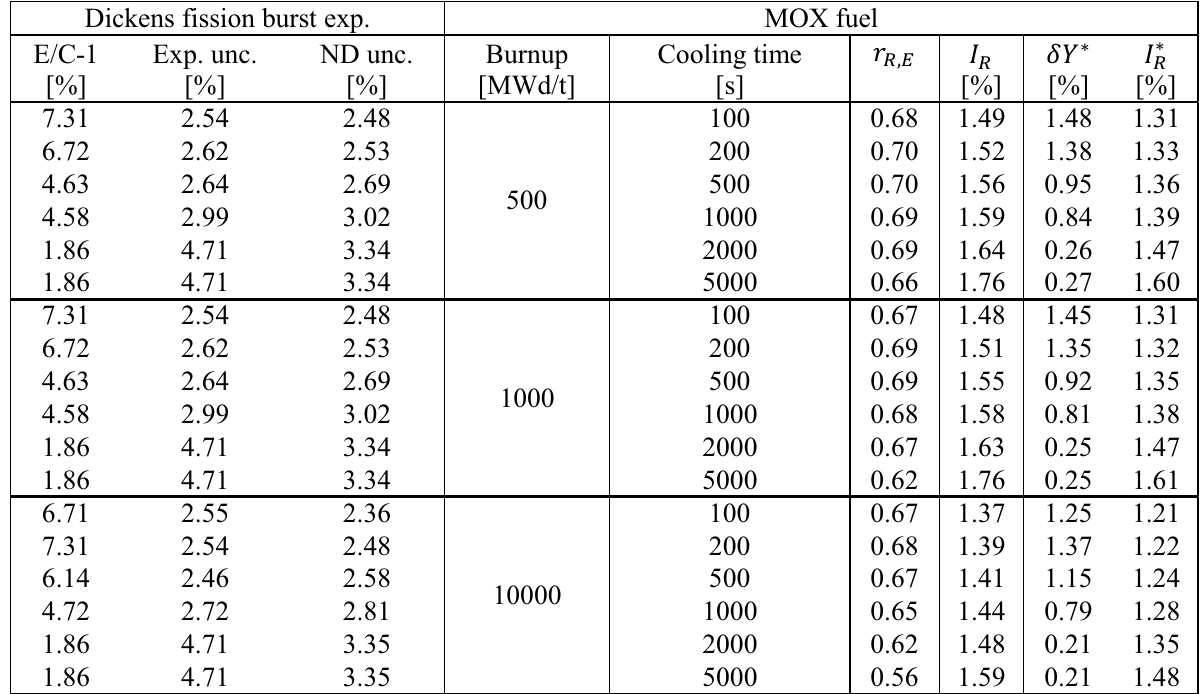
Table I. Transposition results – FY uncorrelated Dickens fission burst exp.